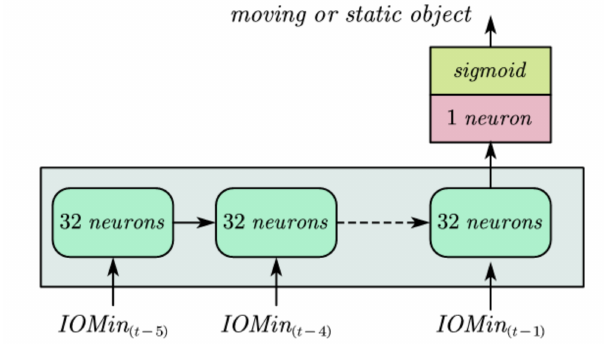
Figure 15. The intersection over minimum volume ( IOMin ) of di ff erent objects in the current frame and the first five frames,